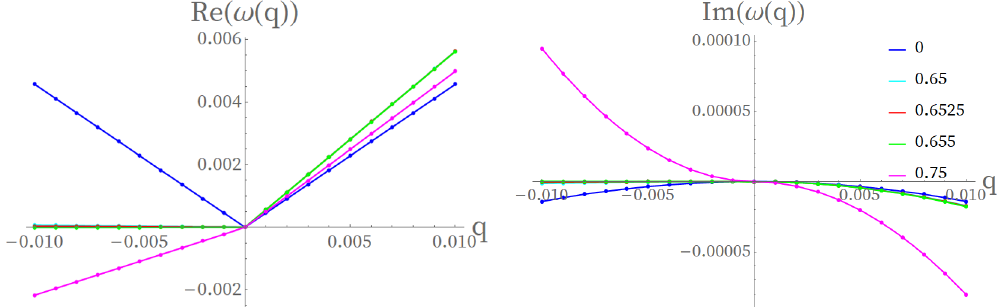
Figure 6. Dispersion relations for sound modes at k = 0 , 0 . 65 , 0 . 6525 , 0 . 655 , 0 . 75 . Left panel shows Re( ω ( q )) and right panel shows Im( ω ( q )) . A universal phenomenon is that Im( ω ( q )) > 0 always accompanies Re( ω ( q )) < 0